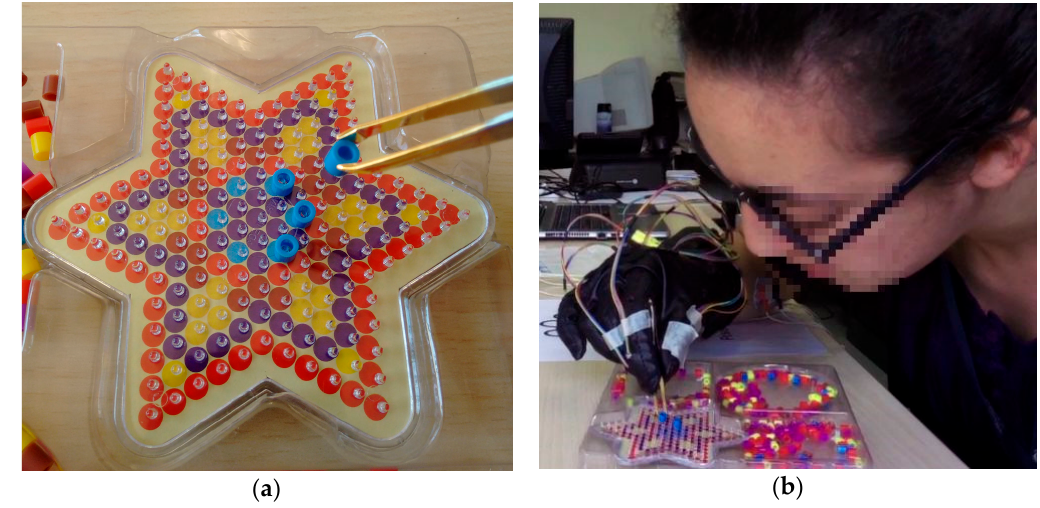
Figure 4. The third exercise of IGlove test: ( a ) Shows the PegBoard, tweezers holding a plastic bushing (PB) and a portion of PBs deposits on the far right of the image. The PegBoard features many pegs, but subjects only need to put six blue PBs on blue pins and one red PB on each peak of the star; ( b ) A picture of one of the volunteers while running the third exercise (she is just placing a blue PB on a blue peg).